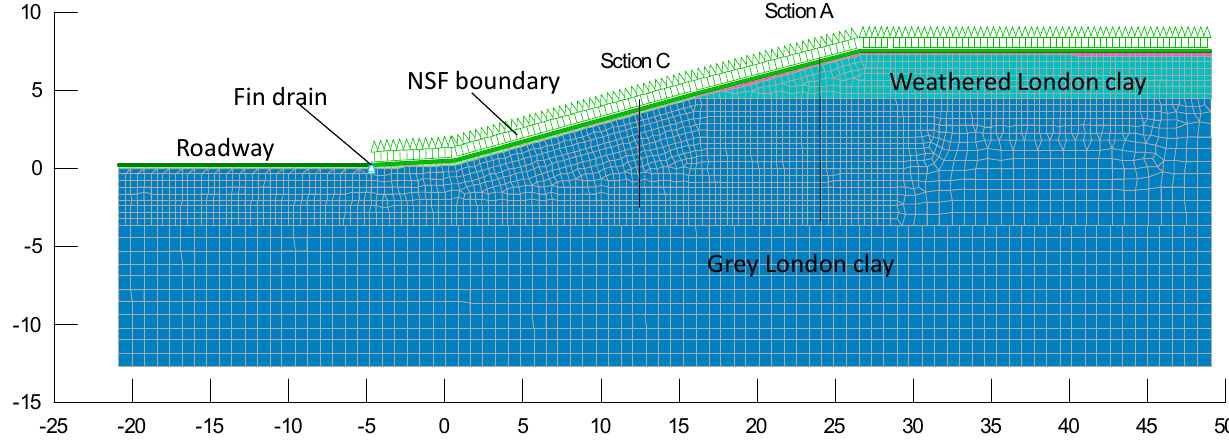
Figure 6. Discretised geometry was used for the SEEP/W analysis (dimensions are in m). The soil in the slope had two distinct subdivisions, namely, weathered London clay and grey London clay layers. They were modelled using different materials. Because of the presence of plant roots and other organic matters, the K of the top surface of the soil slope was higher than the layers below. Separate surface layers (of 0.4 m thickness with element thickness of 0.1 m) using different material models were added to the geometry to account for these differences (i.e., surface layers corresponding to weathered London clay and grey London clay layers). The pore water pressure and other variables usually change rapidly close to the exposed soil surface, i.e., in the surface